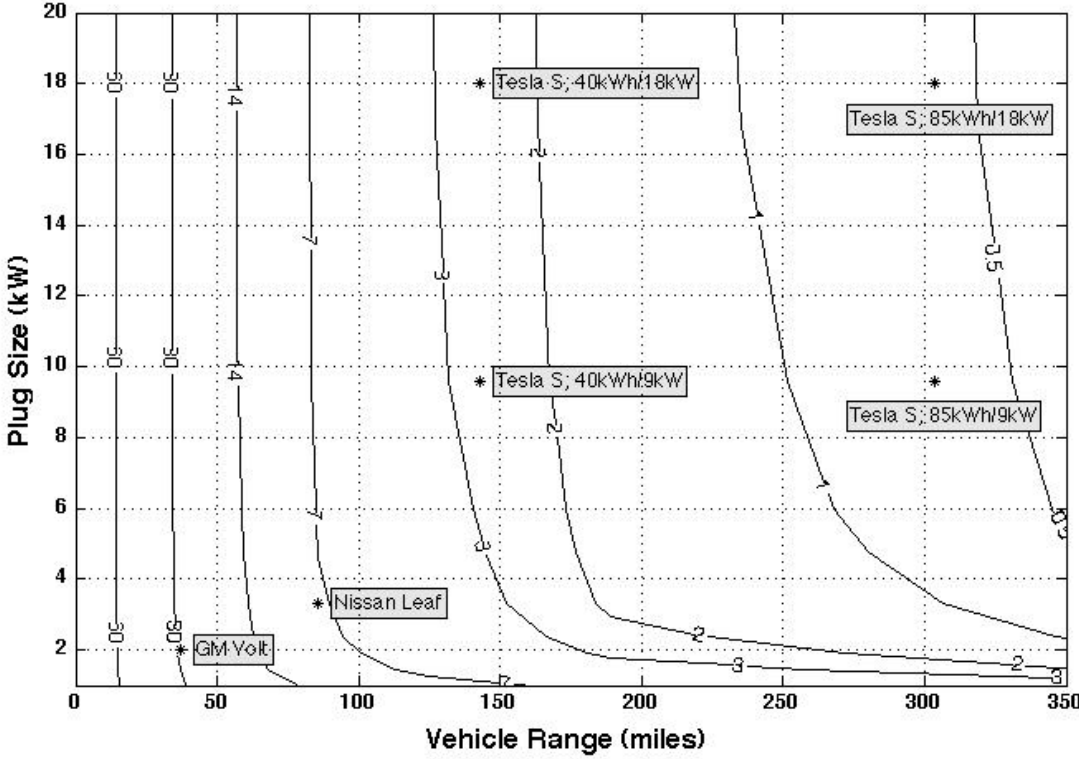
Figure 9. Adaptation days per year among households with multiple vehicles, where the EV is used for the shorter trip, and an available household gasoline vehicle (or a long-range EV) is swapped for the longer trip. Home charging only. Reprinted by permission, from Pearre [24].